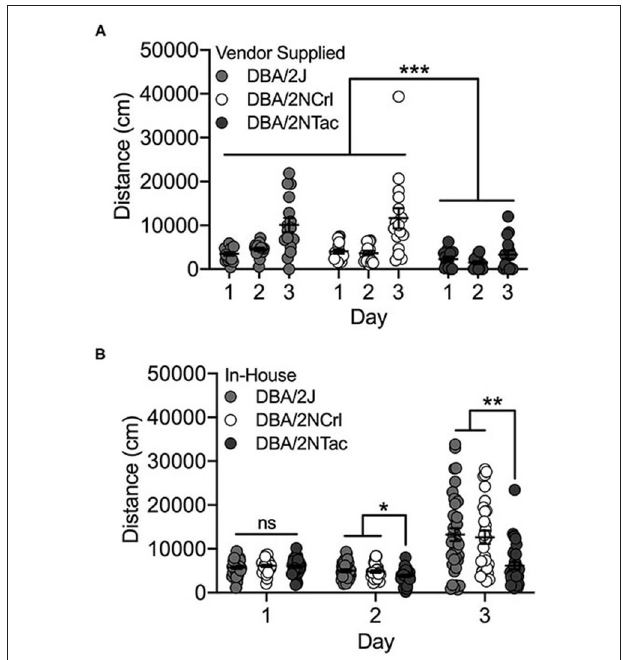
FIGURE 5 | FVB/NJ and FVB/NTac substrains bred in-house differ for saline-induced locomotor activity on Days 1 and 2, but not cocaine-induced locomotor activation on Day 3. (A) Vendor-supplied FVB substrains are significantly activated in response to cocaine exposure on Day 3. FVB/NCrl mice are significantly less active than FVB/NHsd mice. (B) FVB/NTac mice bred in-house are significantly more active than FVB/NJ mice bred in-house following saline exposure on Days 1 and 2, but not following cocaine exposure on Day 3. Each data point represents an individual mouse, error bars are standard error of the mean. ** p < 0.01; *** p < 0.001.